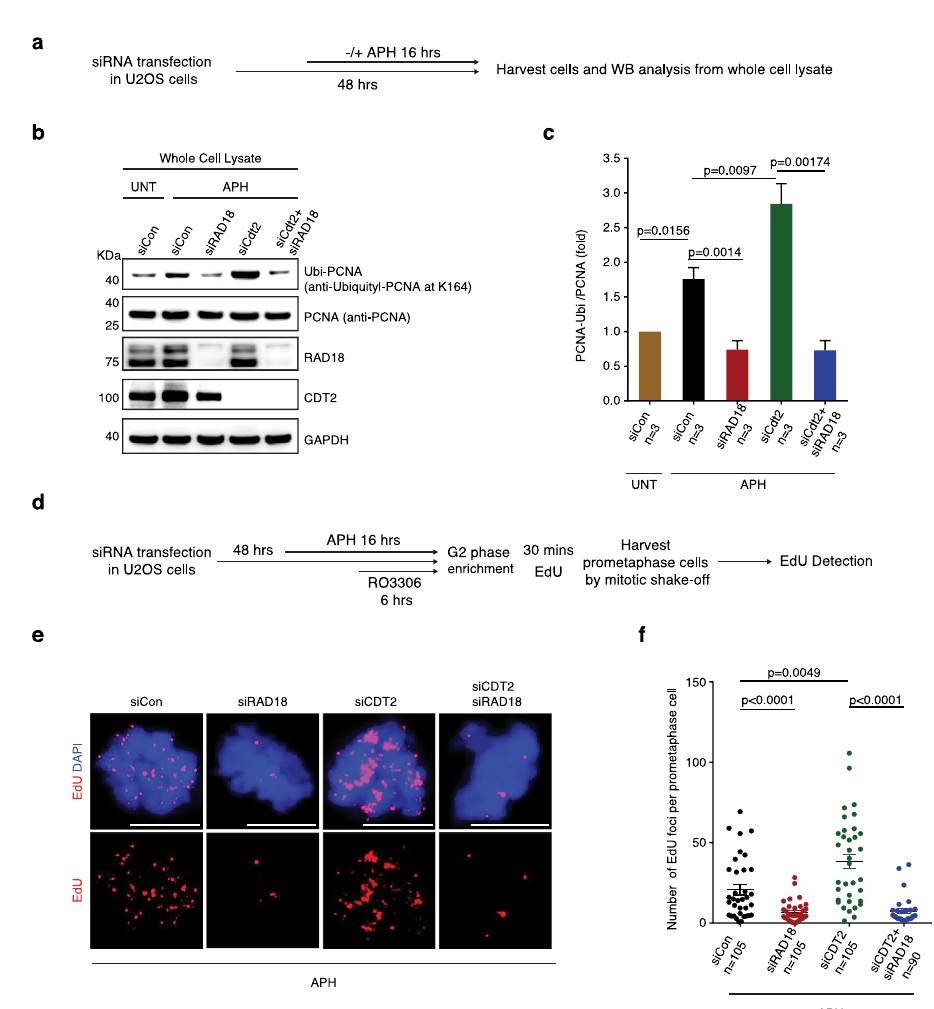
Fig. 3 | RAD18, but not Cdt2, mediates PCNA monoubiquitylation to promote MiDAS. a Experimental work fl ow of Western blot (WB) analysis of asynchronous U2OS cells following different treatment. Representative images ( b ) and quanti fi - cation( c )WBanalysisofPCNAmonoubiquitylationandotherproteinexpressionin whole cell lysate from asynchronous U2OS cells with antibodies speci fi c for PCNA monoubiquitylation at Lys-164, total PCNA, RAD18 or Cdt2. GAPDH was used as a loadingcontrol.Dataofeachbararemeansofindependentexperiments.Errorbars represent SEM. P values were calculated using a two-tailed Student ’ s t -test ( n =3 biological replicates). d Experimental work fl ow for analysis of MiDAS in prometa- phase U2OS cells following RAD18 depletion, Cdt2 depletion or co-depletion of